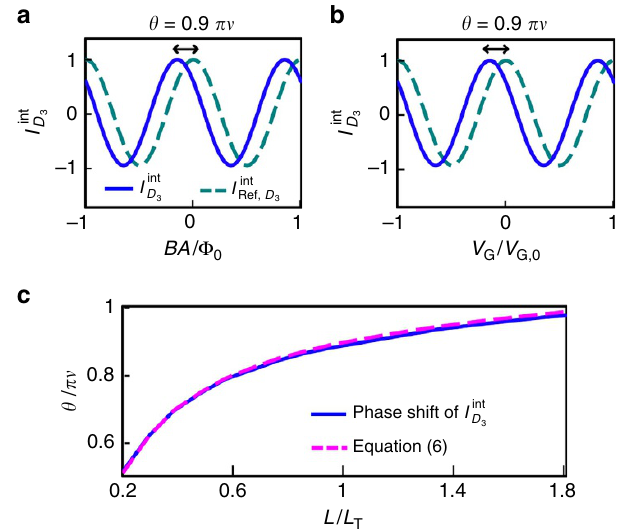
Figure 3 | Detection of anyon phase p n from interference phase shift h . (blue, normalized) and I int (cyan, normalized) on ( a ) Dependence of I int D 3 Ref ; D 3 F in the pure Aharonov–Bohm regime and ( b ) their dependence on V G in the Coulomb dominated regime. We choose n ¼ 1/3, T ¼ 30mK, e * V ¼ 45 m eV, L ¼ 3 m m and v p ¼ 10 4 ms (cid:3) 1 ( L / L T ¼ 1.2 and L / L V ¼ 20); see Supplementary Note 5 for the Coulomb interaction parameter of the and I int is regimes. For these parameters, the phase shift y between I int D 3 Ref ; D 3 0.9 pn . ( c ) Dependence of y on T . The same parameters (except T ) with ( a ) and ( b ) are chosen. y - pn as T increases (yet e (cid:2) V (cid:5) k B T (cid:5) (cid:2) hv p = L ). In both the pure Aharonov–Bohm regime and the Coulomb-dominated regime, the same numerical result (blue curve) of y ( T ), which agrees with equation (6) (magenta), is